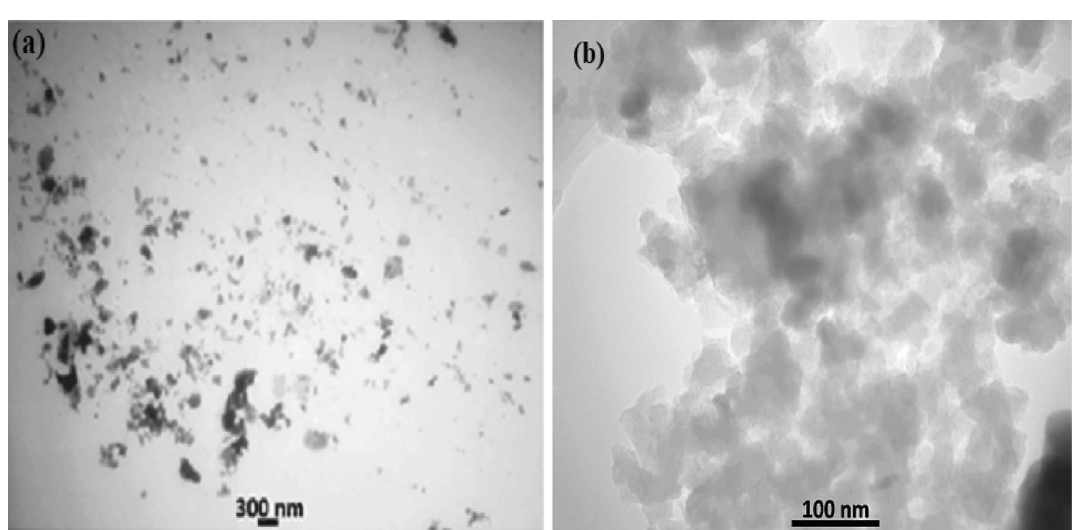
Figure 4. TEM images of ( a ) SnO 2 @ZnO nanocomposites and ( b ) SnO 2 @ZnO.PANI 4%